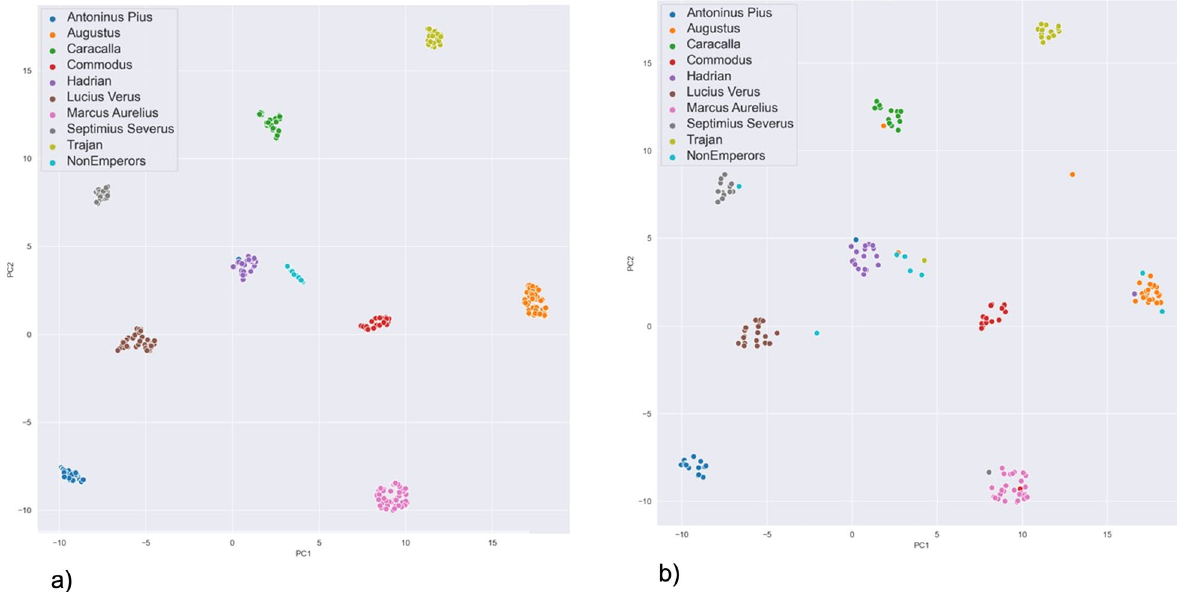
Fig. 9 UMAP projection of embeddings. a Embeddings of the training set. b Embeddings of the validation set. Each point in the maps represents an image embedding of the colour coded emperor. These are points taken from the penultimate dense layer of the model from experiment 2, which is a 512- dimension representation. Observe that the same emperor embeddings are grouped well together and are well separated from one